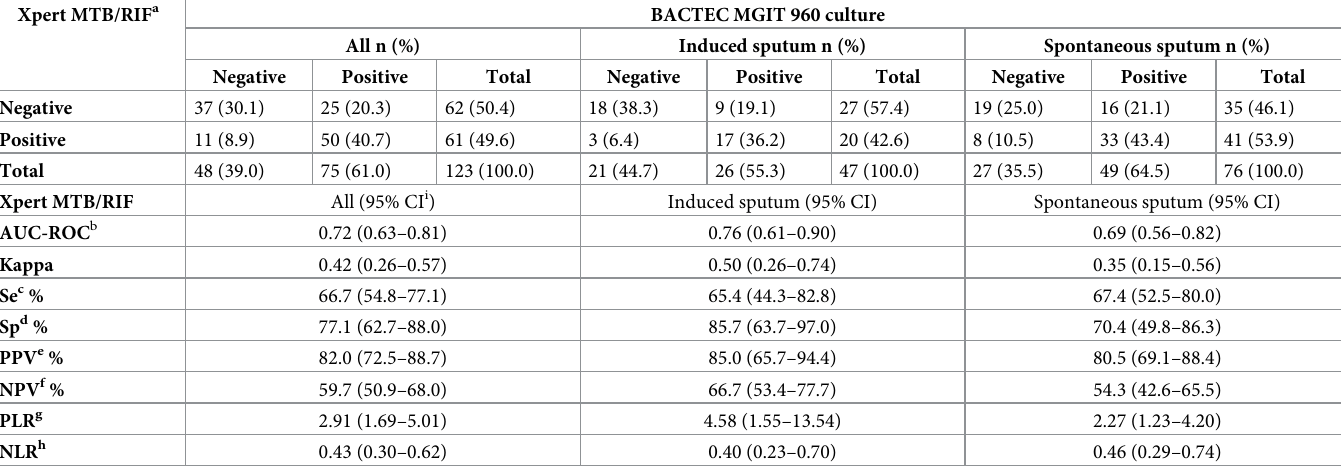
Table 2. Performance of Xpert MTB/RIF assay against BACTEC MGIT 960 culture as the reference standard.